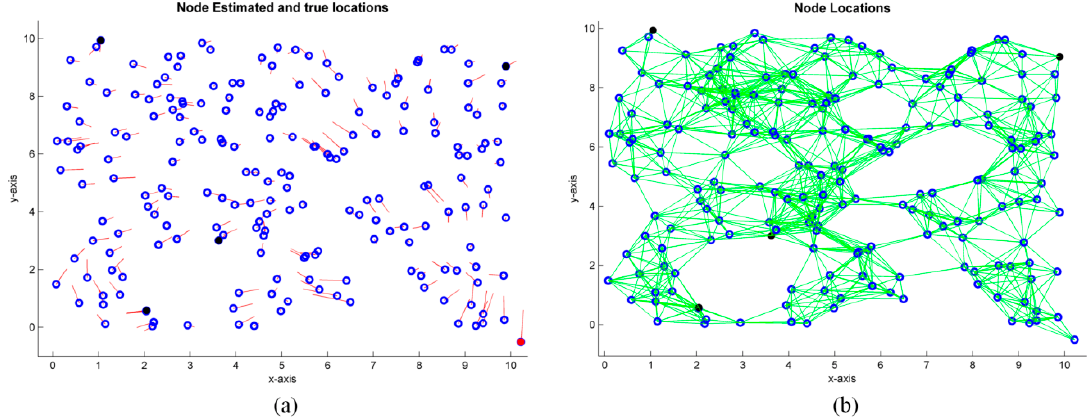
Figure 9. 200 nodes randomly distributed. ( a ) True node positions ( ) and error with respect to the estimated node positions ( ). ( b ) True node positions and associated graph to the WSN with 𝑅 = 1.5𝑟.